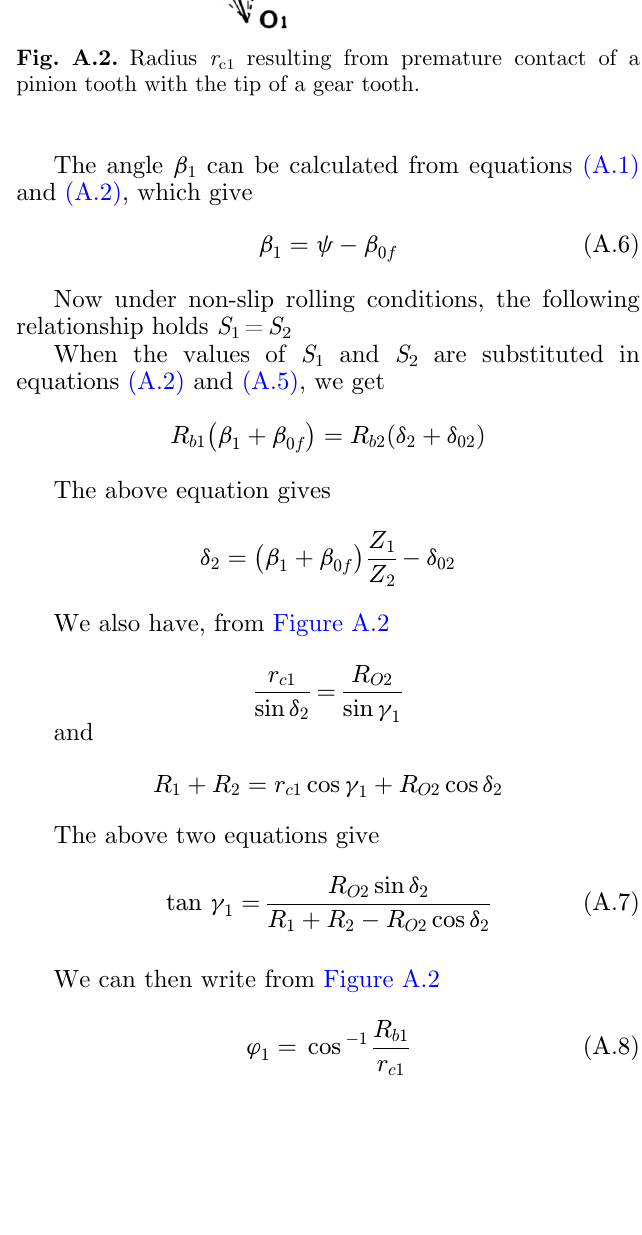
Fig. A.1. De fi nition of the distance S from the point of contact to the primitive point P